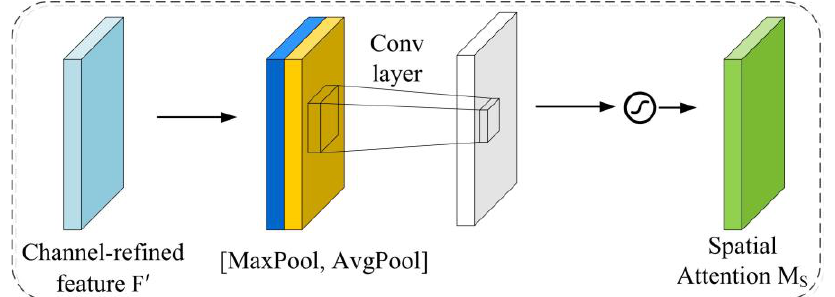
Figure 7. Spatial attention structure.